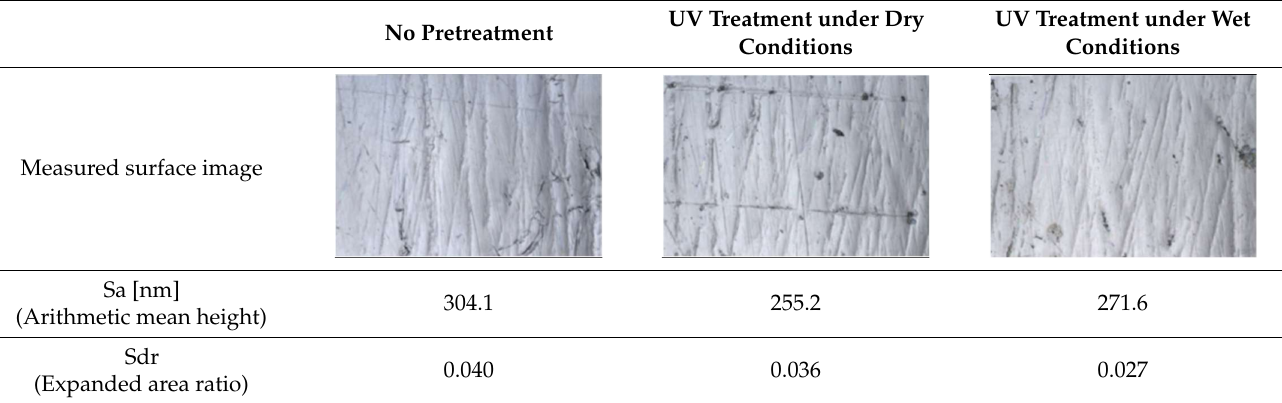
Table 4. Surface roughness measurement result of each condition of the A504A90B test